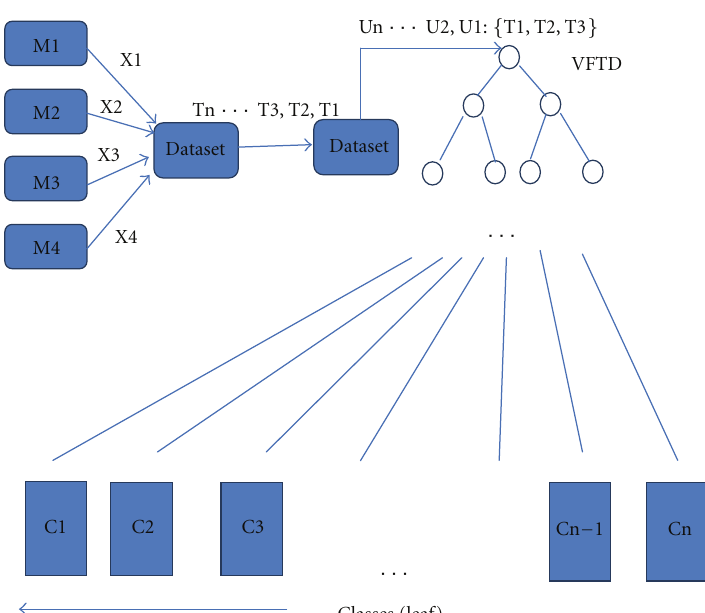
Figure 2: Classification by VFDT.